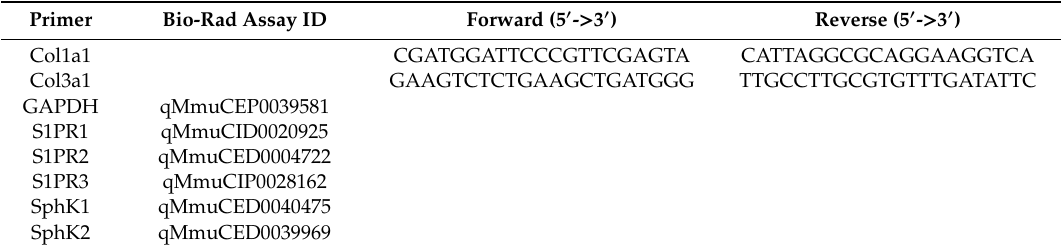
Table 1. The primers used for quantitative real-time